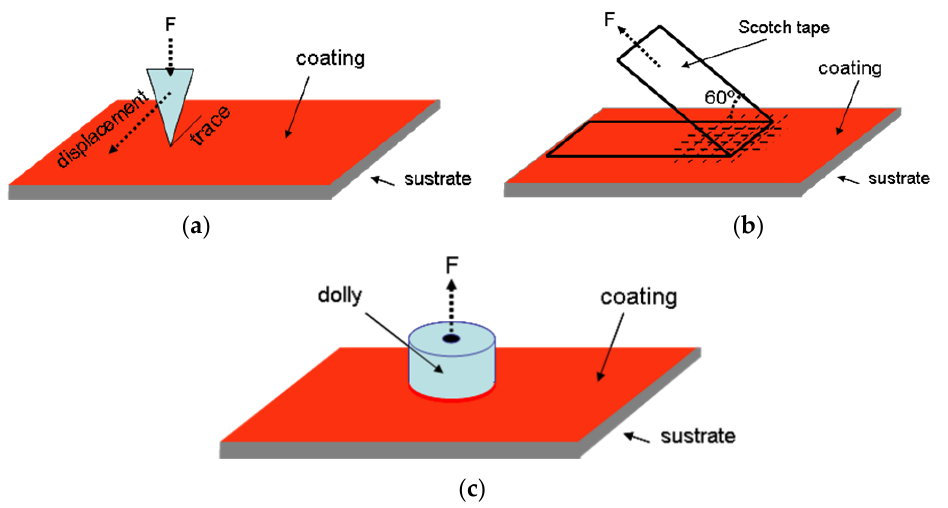
Figure 1. Schemes of ( a ) scratch test, ( b ) cross-cut test, ( c ) adhesion pull-off test.